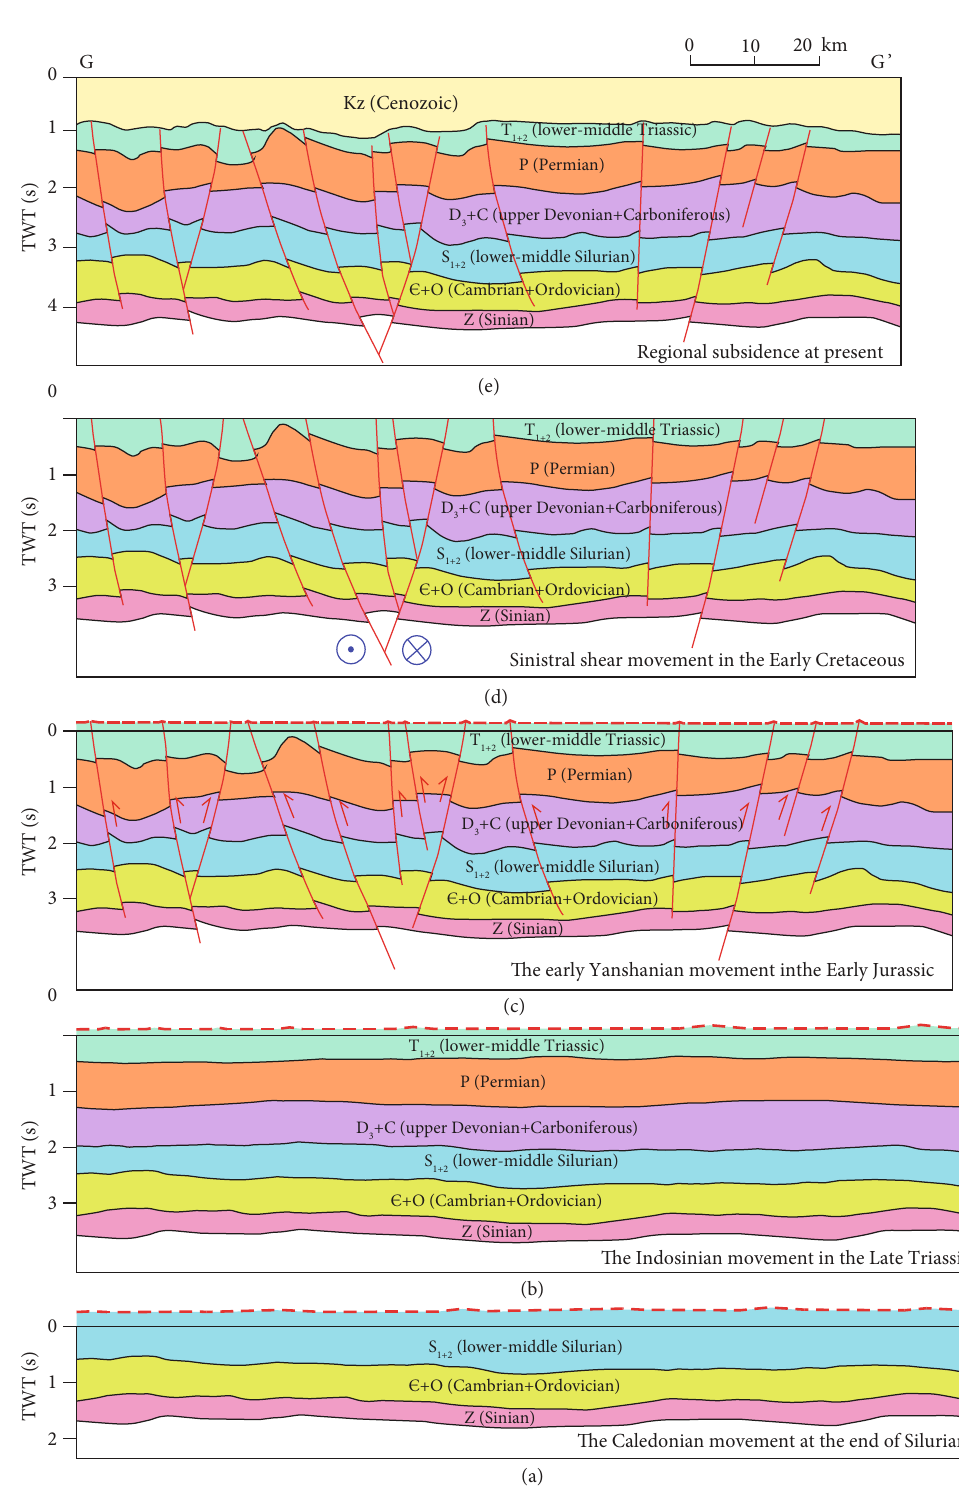
Figure 4: NE-SW-trending tectonic evolution section of the Wunansha Uplift, South Yellow Sea basin (see Figure 1 for pro fi le